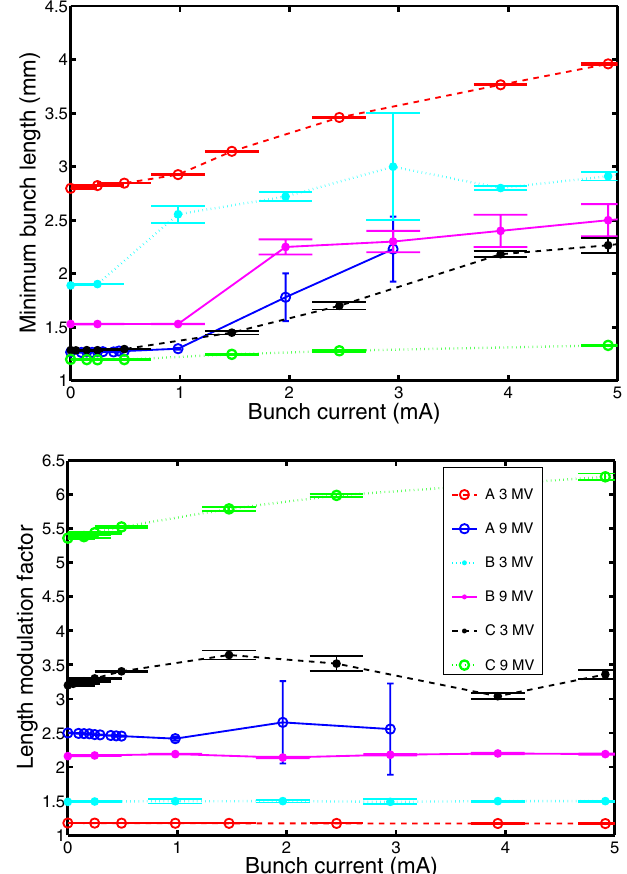
FIG. 9. (Color) Minimum bunch length and length modulation factor as a function of current (up to 5 mA) by considering all the wakefield